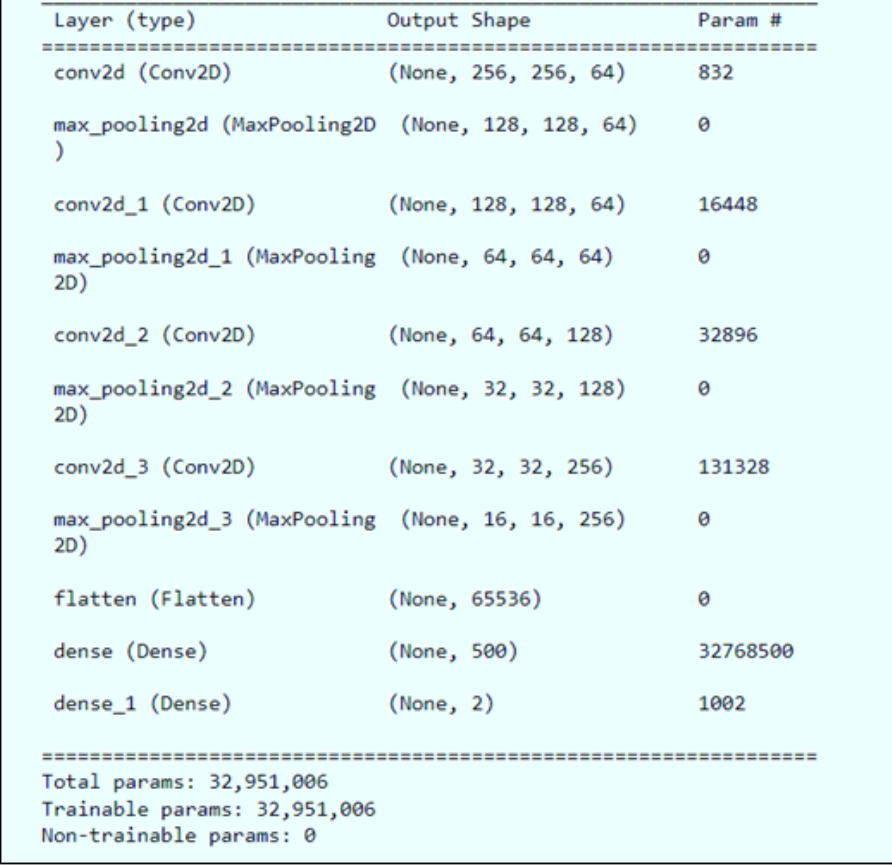
Figure 5. Description of the proposed